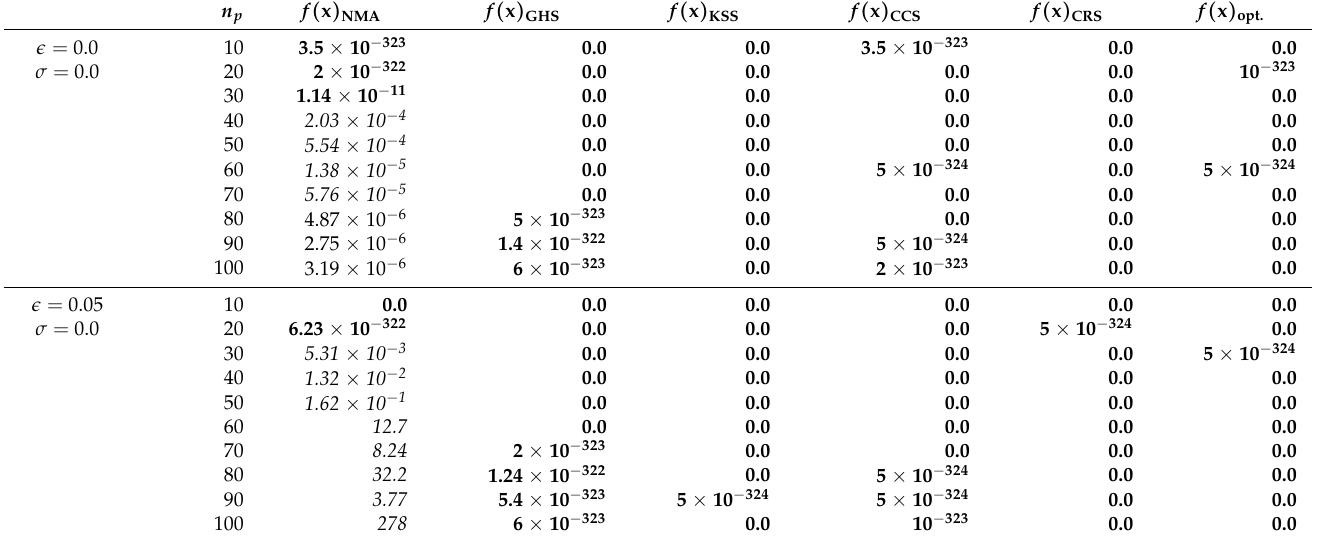
Table 1. Accuracy of the original NMA, the existing adaptive schemas (GHS, KSS, CCS, CRS), and the optimized schema on Gao–Han (GH) modified quadratic benchmark